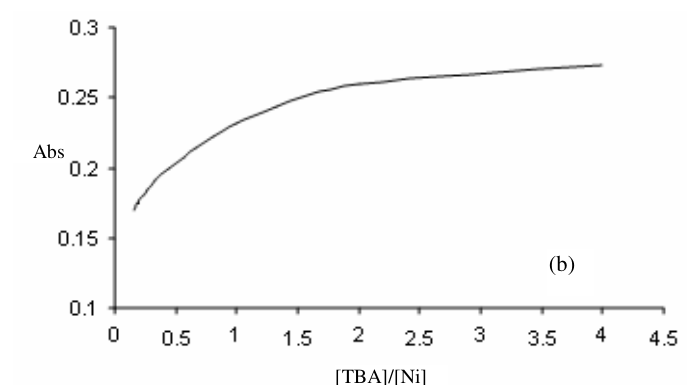
Figure 3. UV-Vis spectra for titration of TBA (1 × 10 -5 M) with Ni 2+ (5 × 10 -4 M) in deionized water (Ic = 0.2 (%w/v) NaCl, λ = 264 nm, T = 25 o C, pH = 6) (a), and the corresponding max molar ratio plot (b).